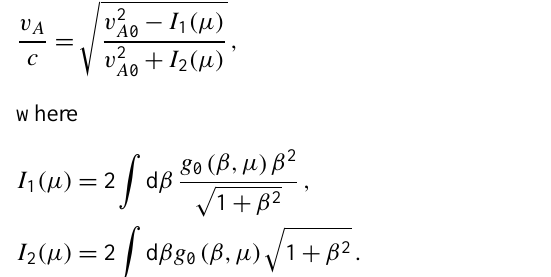
Fig. 8. Alfvén speed as a function of inverse normalized tempera- ture of µ . (a) Eq. (42) and (b) Eq. (30) ( β = 0), for various values of v A 0